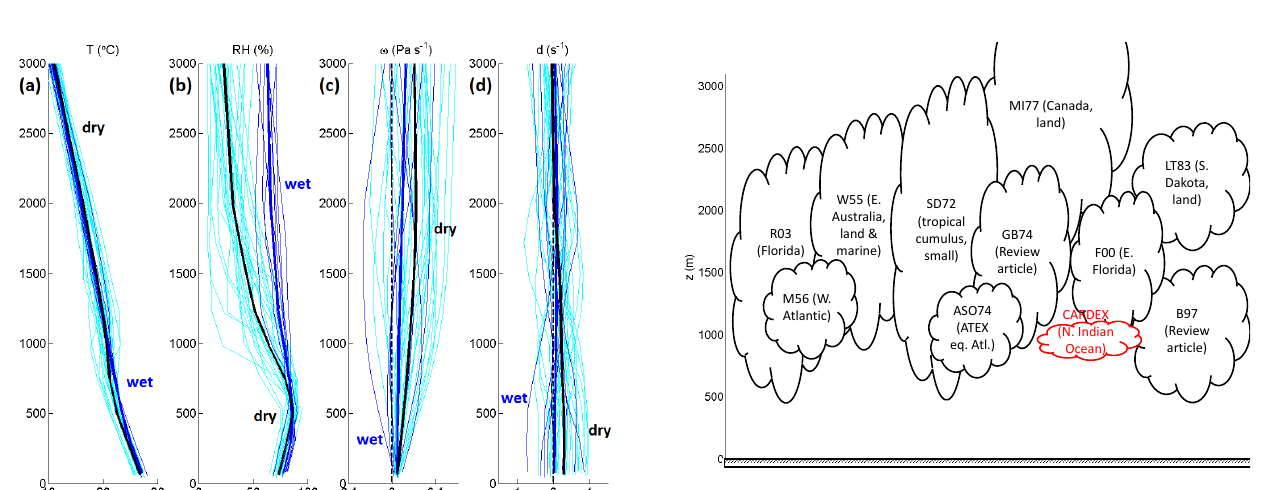
Figure A4. Previous descriptions of small cumulus according to the literature. Note that some clouds, especially those measured over land, are physically larger than the clouds observed in the Indian Ocean during CARDEX. References are those in Table